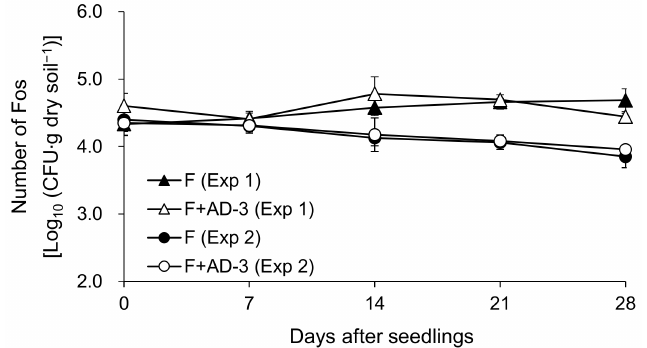
Figure 2. Density of Fusarium oxysporum f. sp. spinaciae (Fos) (plots ± SD) in soil after seedling emergence. SD, standard deviation of the means. Each plot represents the average of three replicates (pots). The experiment was repeated twice (Exp 1 and Exp 2).